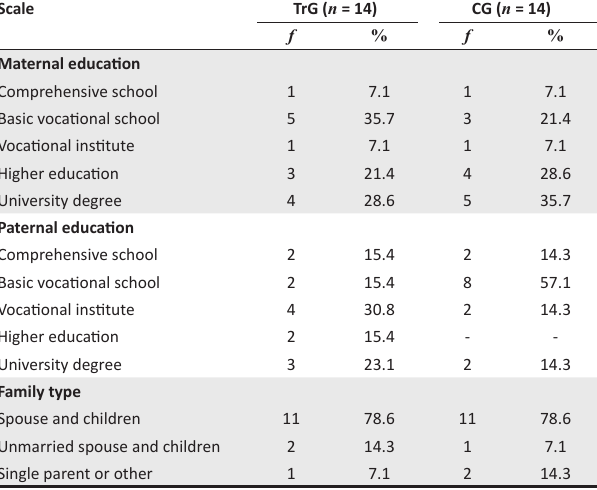
TABLE 1: Demographic information and baseline measures .